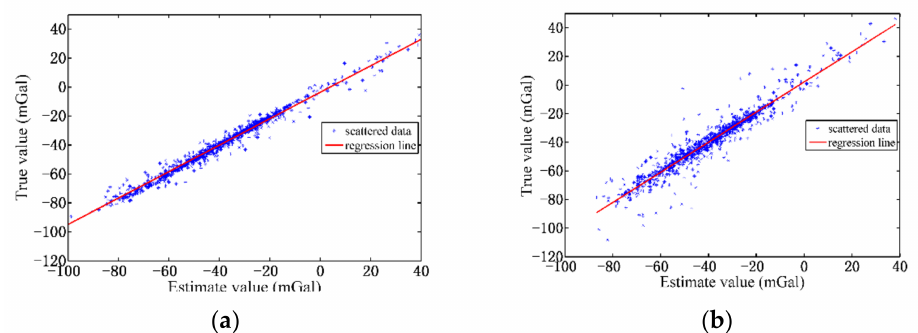
Figure 5. Regional gravity anomaly model, namely the discrete data interpolation results. ( a ) GR_TCFWO model map constructed by TCFWO method. ( b ) GR_KR model map constructed by kriging algorithm.